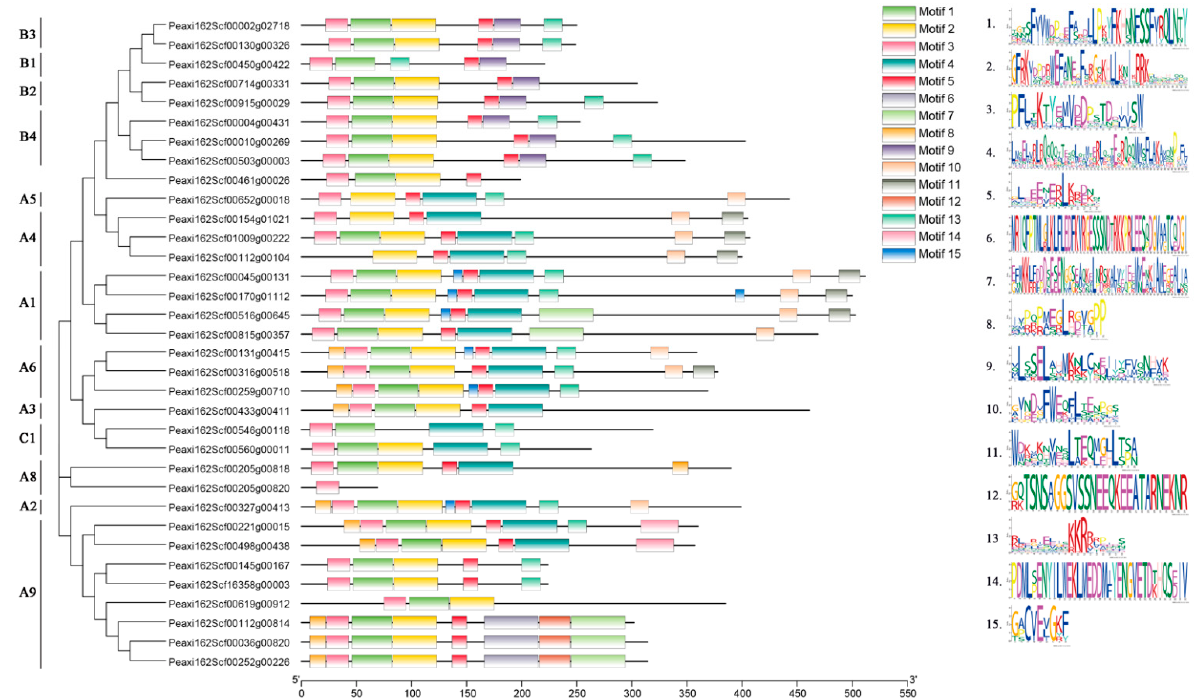
Figure 3. Conserved motif analysis of petunia HSFs. Proteins are organized according to the groups in Figure 2. Fifteen motifs are found in the protein sequences.